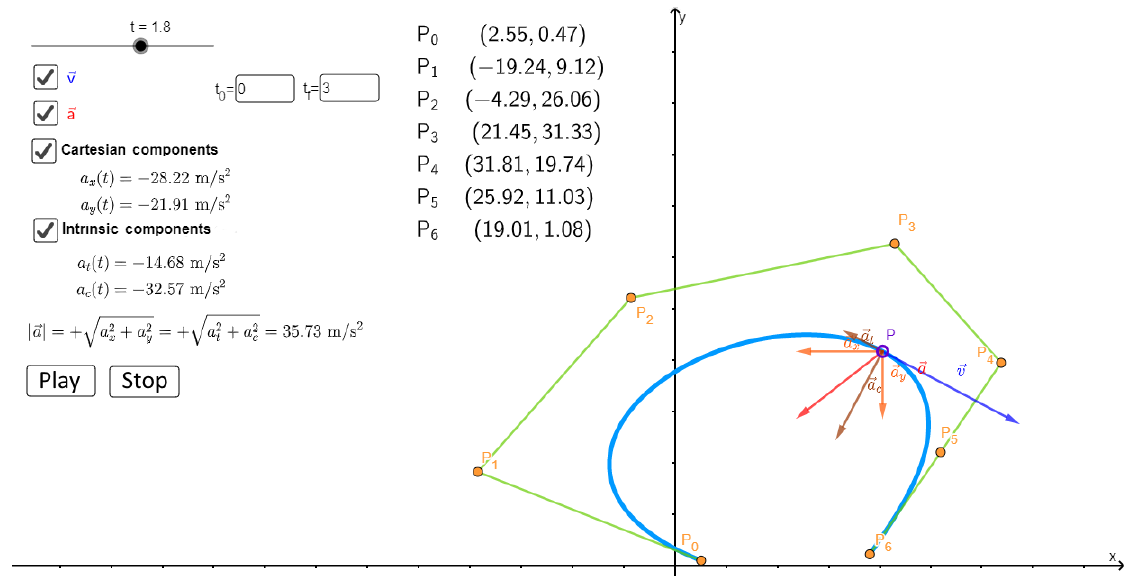
Figure 2. A particular example of robot path design using Bézier cuvers with the GeoGebra applet.